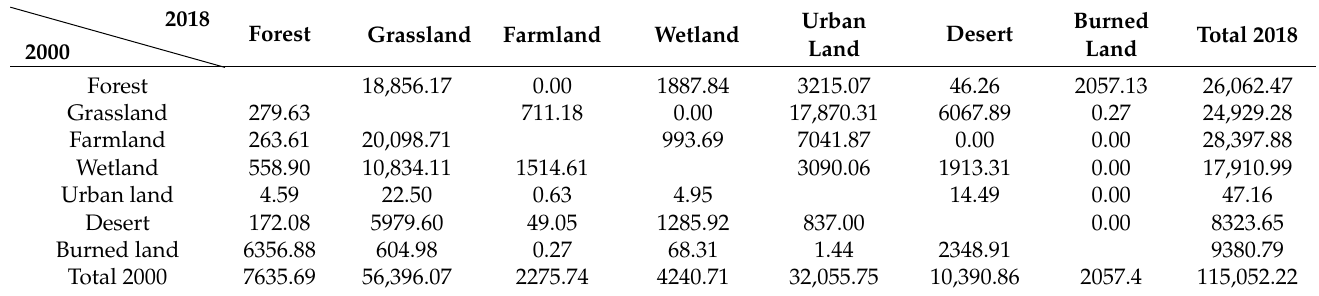
Table 2. Land cover transition matrix from 2000 to 2018 (hm 2 ).